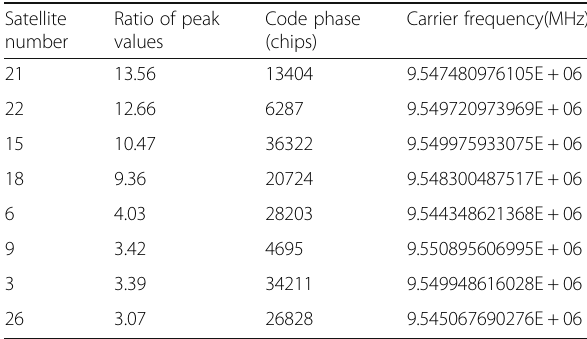
Table 2 The satellite data captured by the GPU experimental platform